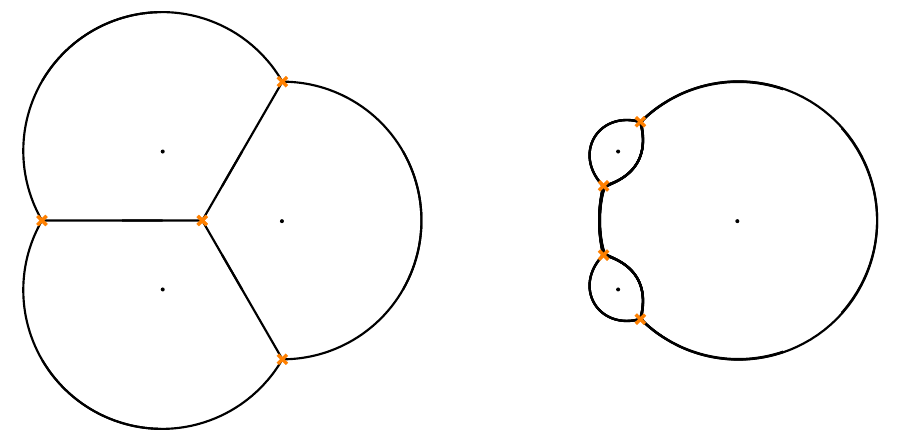
Figure 11. Two BPS graphs for the SU(2), N f = 4 theory.